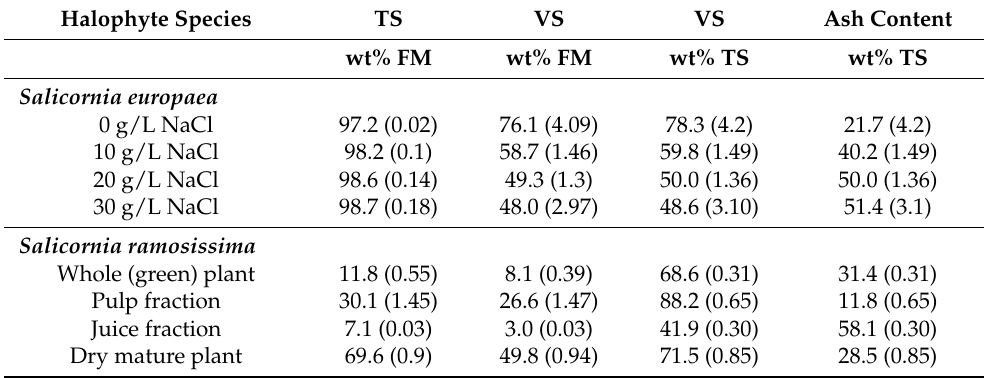
Table 1. TS, VS and ash content of Salicornia samples in wt% of fresh mass (FM) and wt% of TS, standard deviation of triplicates in parentheses. For Salicornia europaea the biomass values after drying of the fresh plant material are